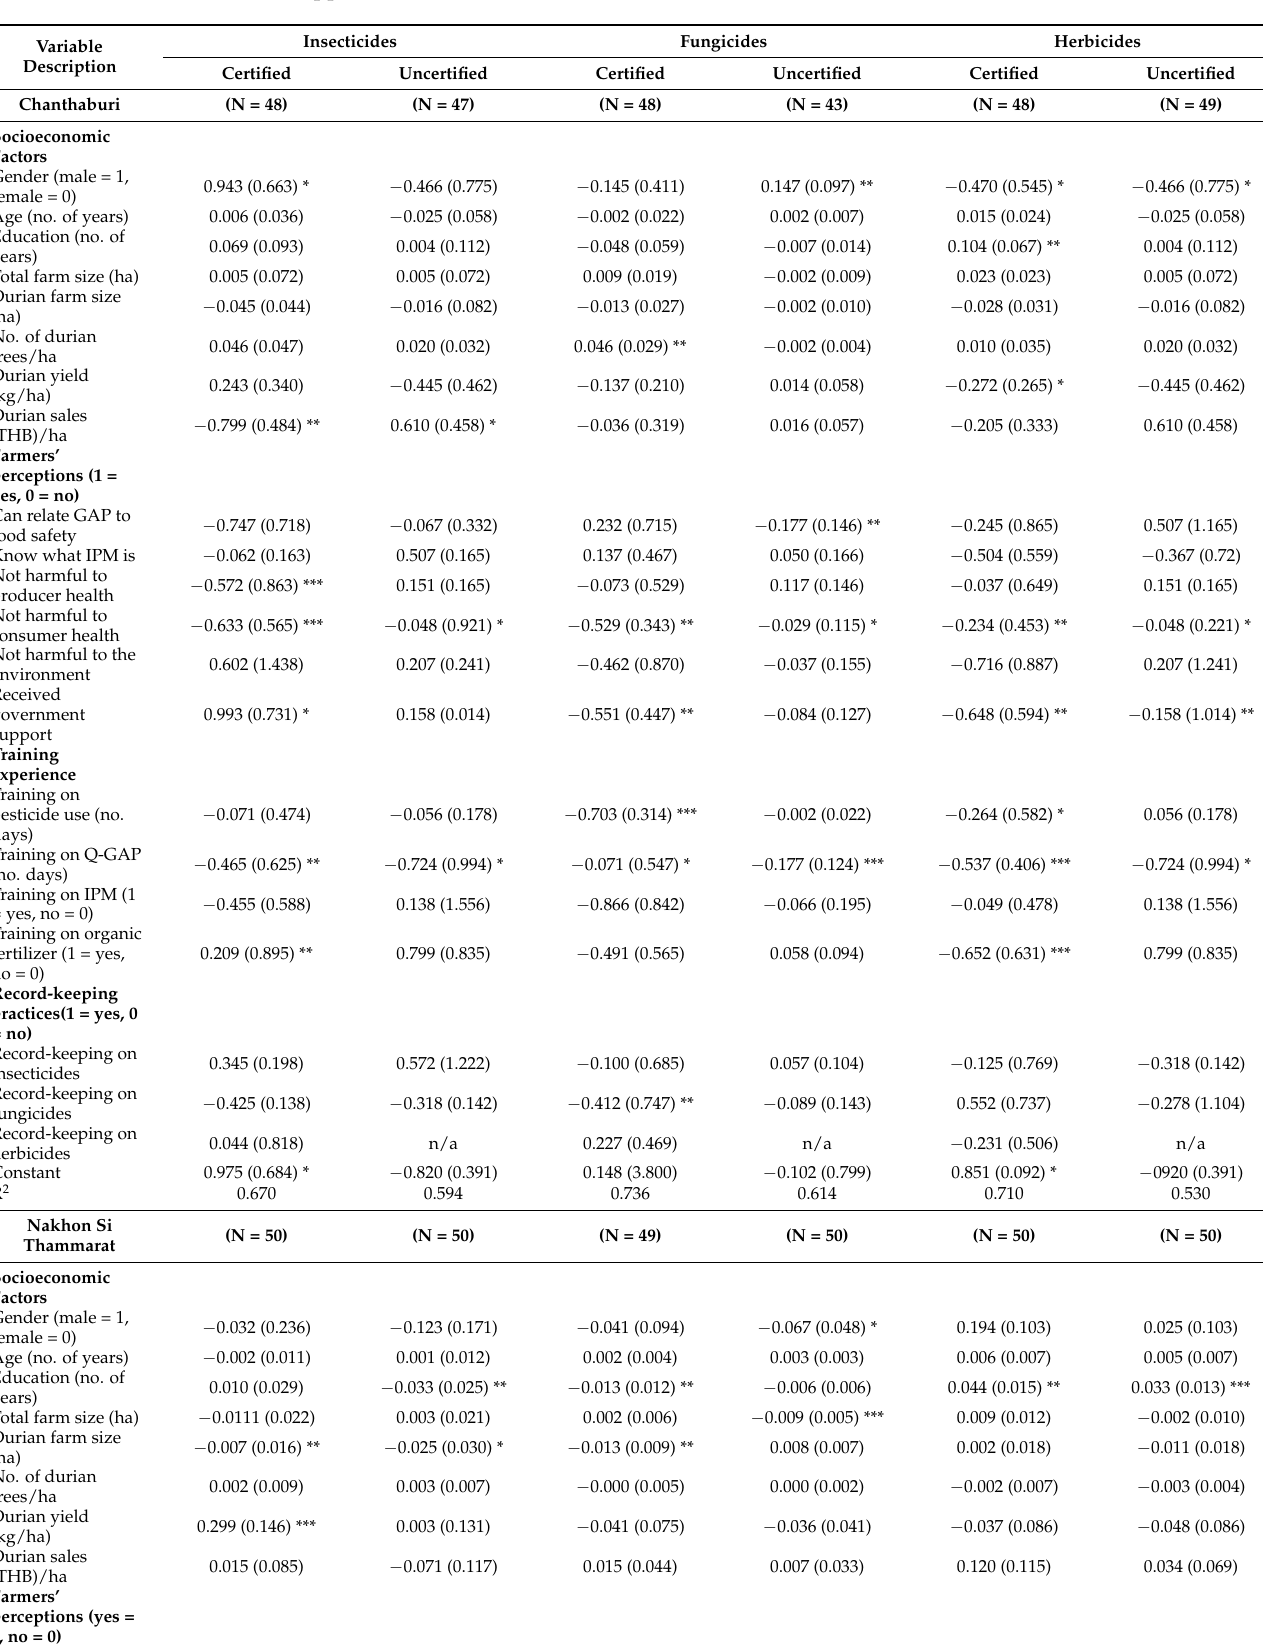
Table 11. Influence of various factors on the quantity of insecticides, fungicides, and herbicides applied (all the variables considered are